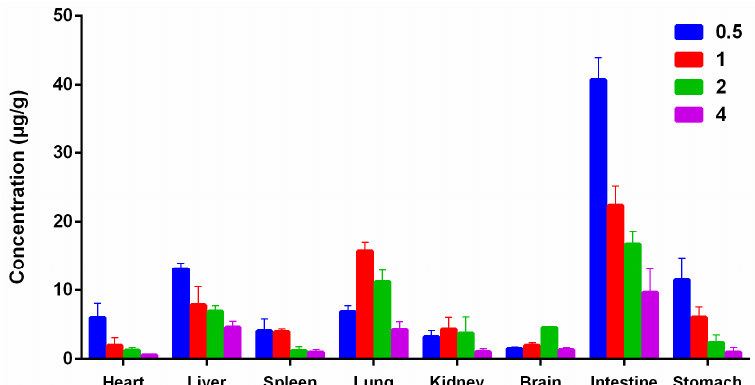
Figure 4. Tissue distribution in rats after a single intravenous administration of 10 mg / kg gardneramine ( n = 5).